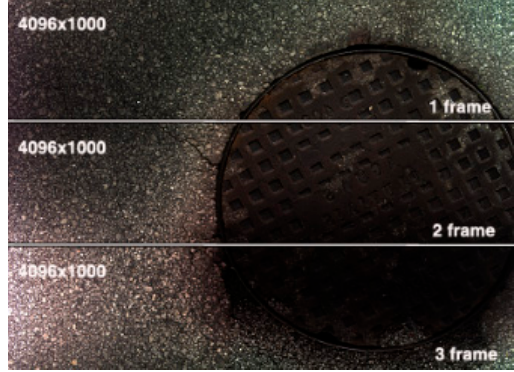
Figure 7. Three consecutive frames with a resolution of 4096 × 1000 pixels on each frame obtained at a travel speed of 20 km/h.